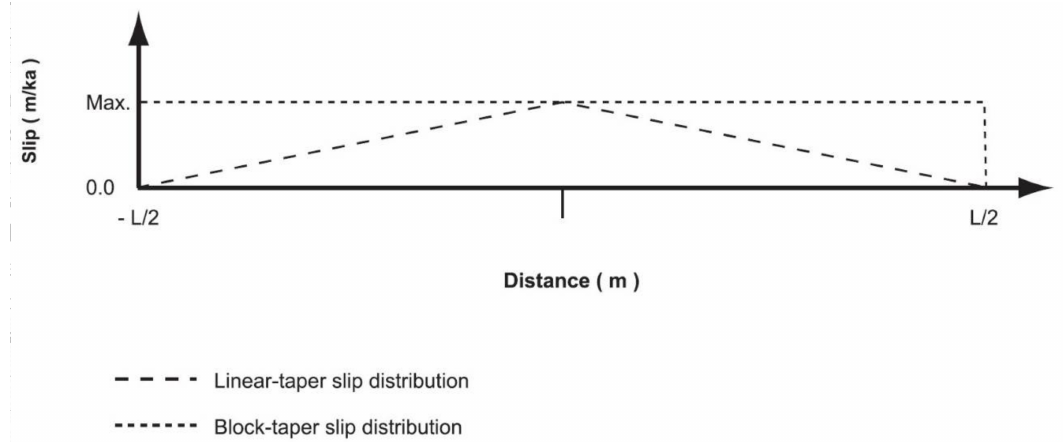
Figure 4. Illustration of the two different slip distributions considered, after Bernal et al.